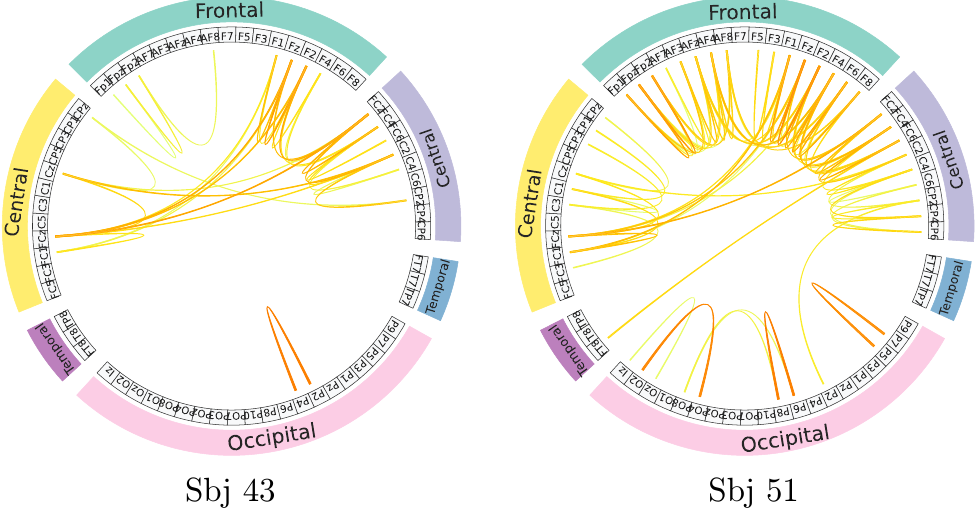
Figure 6. Connectivity maps are estimated for the best-performing ( left side ) and poorest-performing ( right side ) subjects. Stronger correlations between nodes are represented by darker edges linking two EEG channels. The right plot shows the brain regions (i.e., Temporal, Frontal, Occipital, Parietal, and Central) colored differently to improve spatial